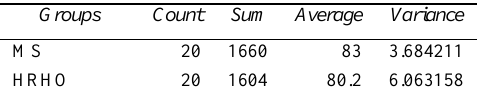
Table 2 Data Sets runs summary